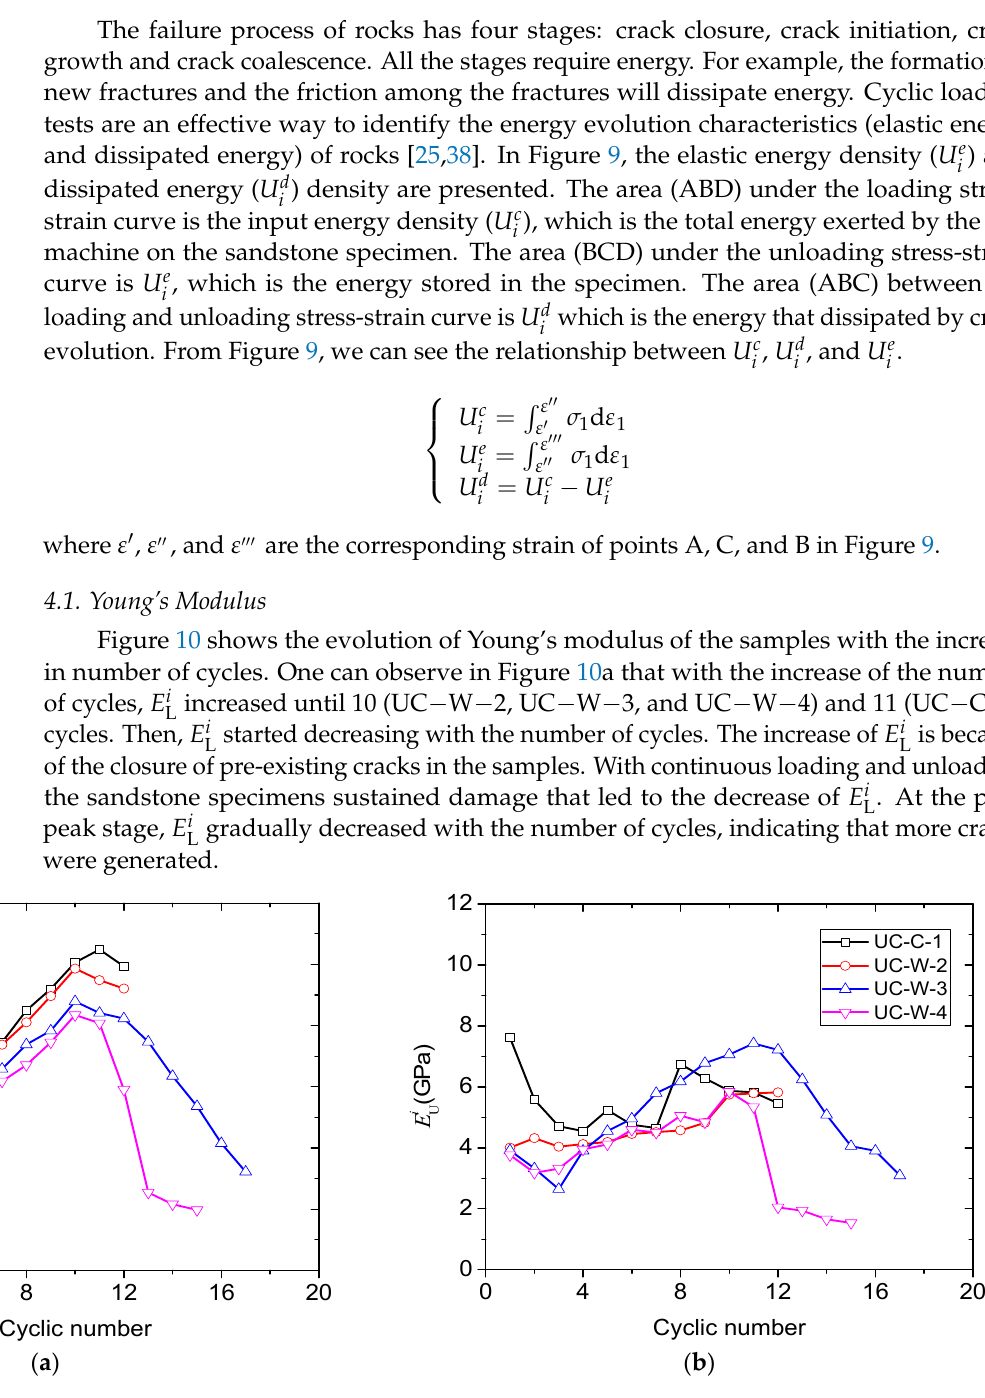
Figure 10. Variations of the loading Young’s modulus and unloading Young’s modulus with number of cycles: ( a ) relationship between loading Young’s modulus and cyclic number and ( b ) relationship between unloading Young’s modulus and number of cycles.